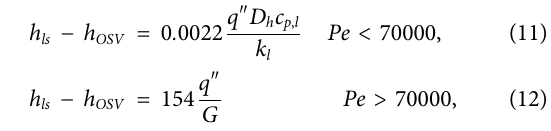
Frontiers in Energy Research |